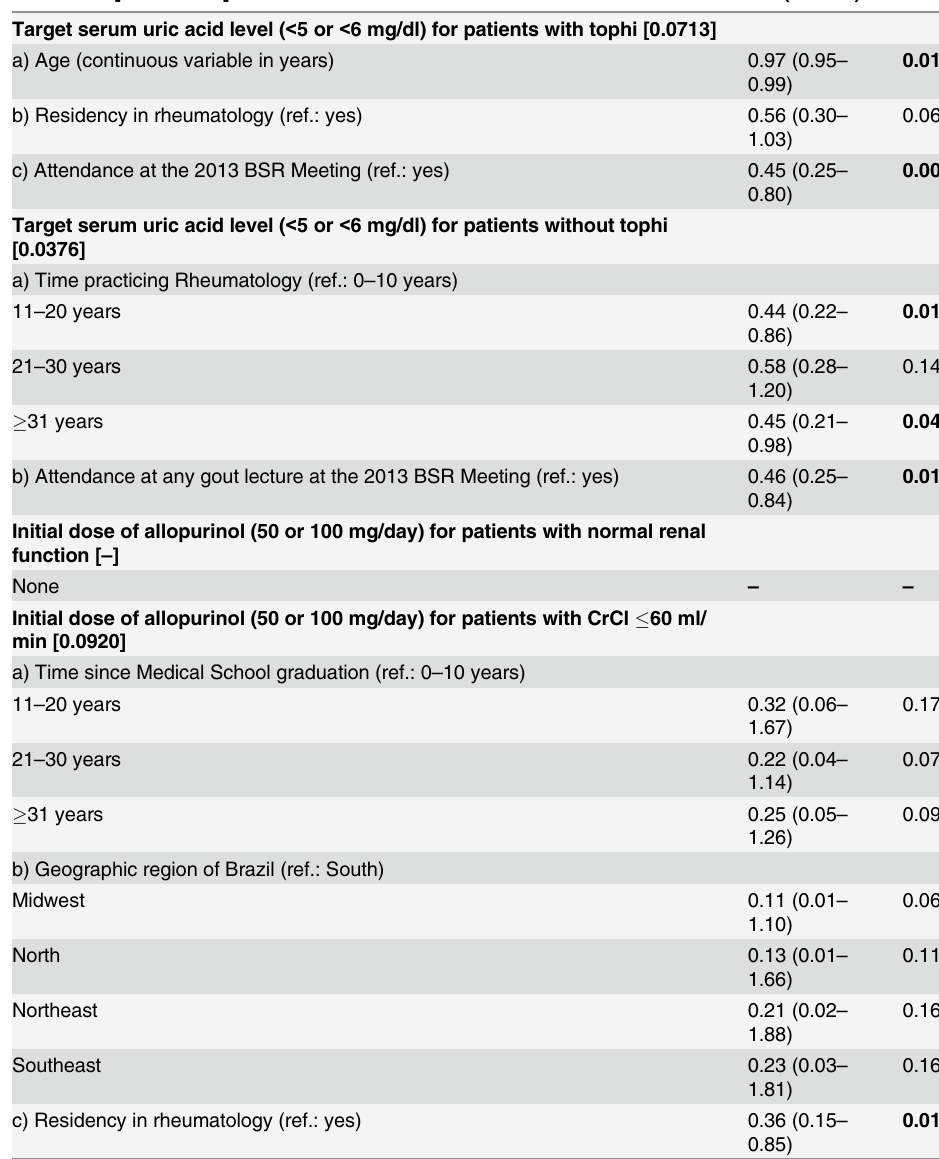
Table 6. Multivariate-adjusted predictors of concordance between reported urate-lowering therapy management and the 2012 ACR gout guidelines. Outcomes [Pseudo R2] OR (CI 95%) P Target serum uric acid level ( < 5 or < 6 mg/dl) for patients with tophi [0.0713] a) Age (continuous variable in years) 0.97 (0.95 – b) Residency in rheumatology (ref.: yes) 0.56 (0.30 – c) Attendance at the 2013 BSR Meeting (ref.: yes) 0.45 (0.25 – Target serum uric acid level ( < 5 or < 6 mg/dl) for patients without tophi